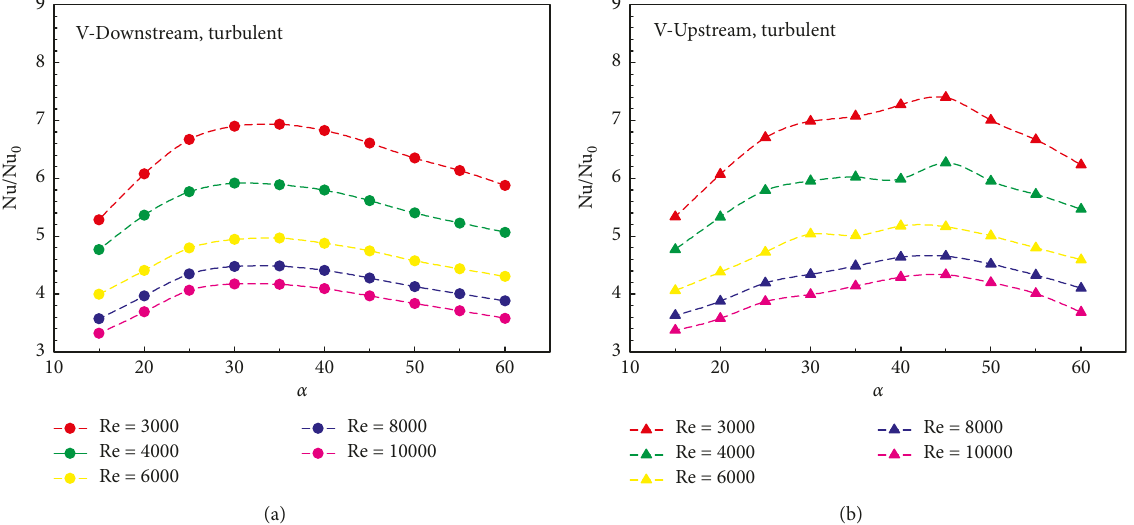
Figure 24: Relations of Nu/Nu 0 with α for the heat exchanger tube inserted with the V-wavy surface for (a) V-Downstream and (b) V- Upstream at the turbulent regime.